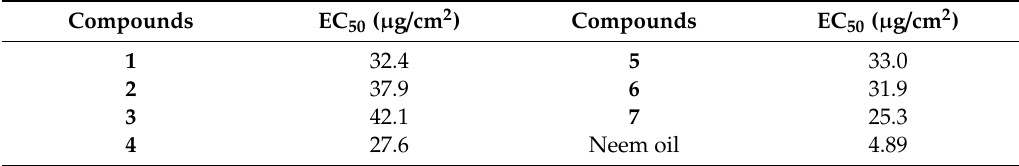
Table 2. Antifeedant activity of compounds 1 – 7 against P.